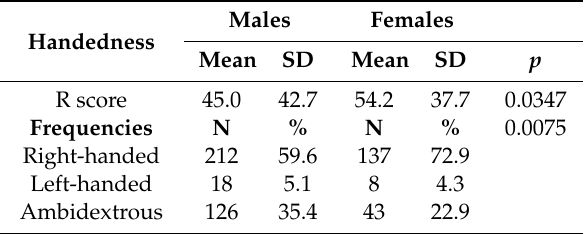
Table 2. R scores (mean and SD) and frequencies of hand preference (according to Edinburgh Handedness Inventory (EHI)) by sex.